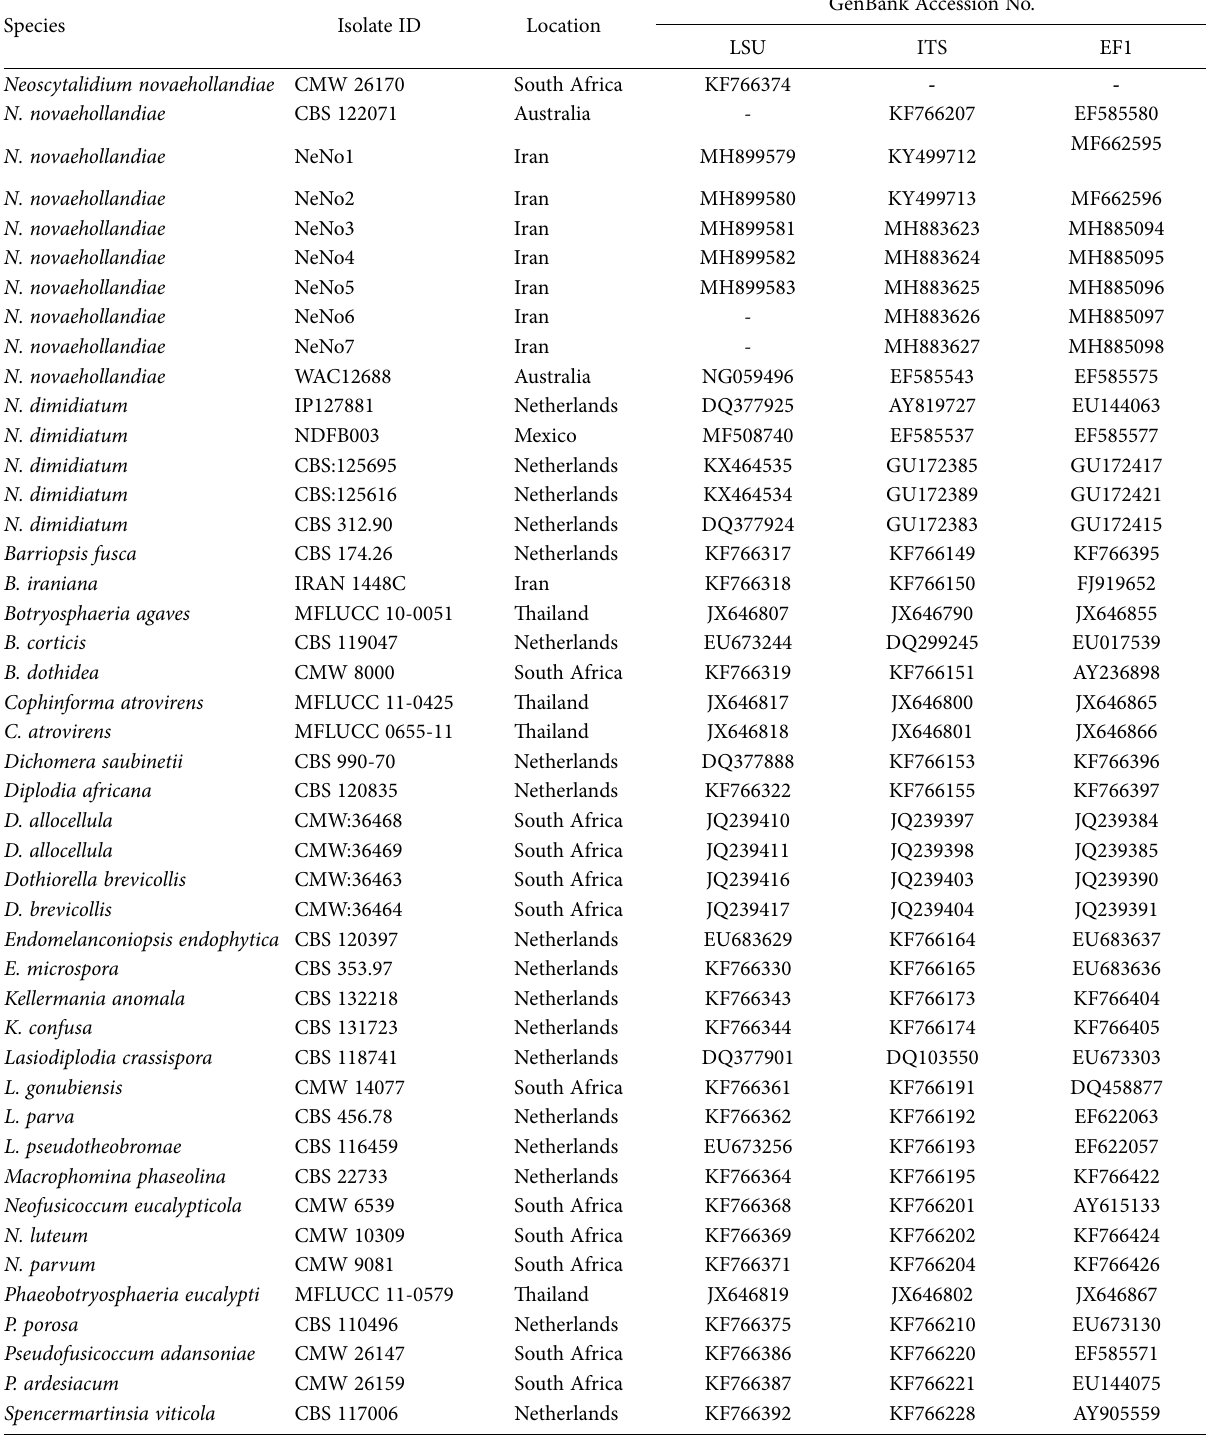
Table 1. Isolates of fungi used in this study, their locations and their NCBI GenBank. Sequence accession numbers for the Large Subunit of the nuclear ribosomal RNA (LSU), Internal Transcribed Spacer (ITS) and Translation elongation factor 1-alpha (EF-1) gene portions.